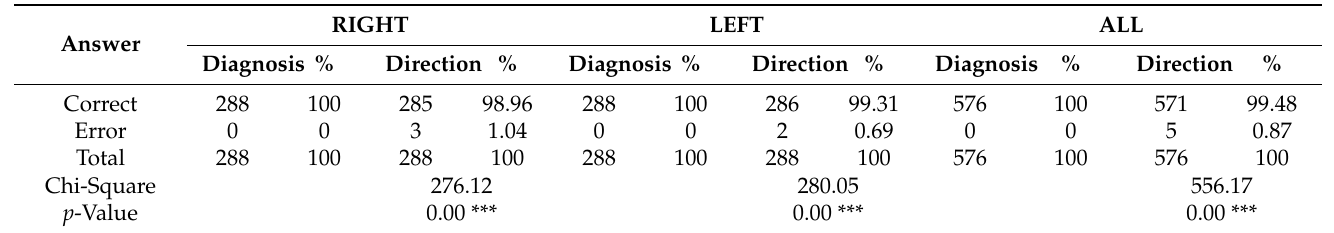
Table 4. Validity of OCI at Grade II (2 ◦ and 3 ◦ ).